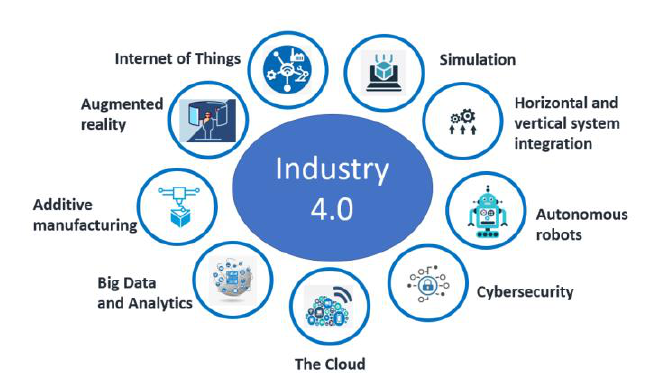
Figure 1. The nine technological pillars of Industry 4.0 (Adaptable from Rüßmann